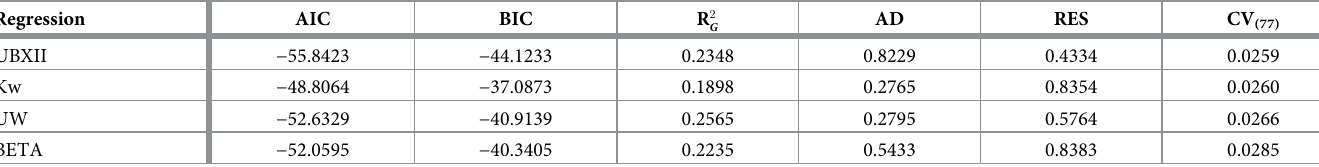
Table 5. Goodness-of-fit measures and LOOCV statistic for the fitted regressions.